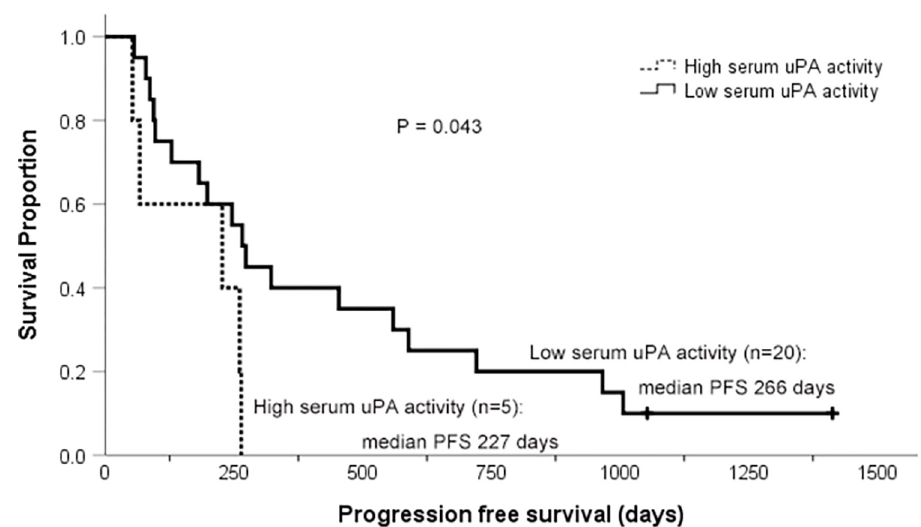
Fig 3. Kaplan-Meier curves for dogs with low or high serum uPA activity. Kaplan-Meier curves for progression free survival (PFS) of dogs with osteosarcoma treated with a limb amputation and carboplatin chemotherapy. Median PFS was 266 days for dogs with low serum uPA activity (n = 20, solid line) and 227 days for dogs with high serum uPA activity (n = 5, dashed line; p = 0.043).